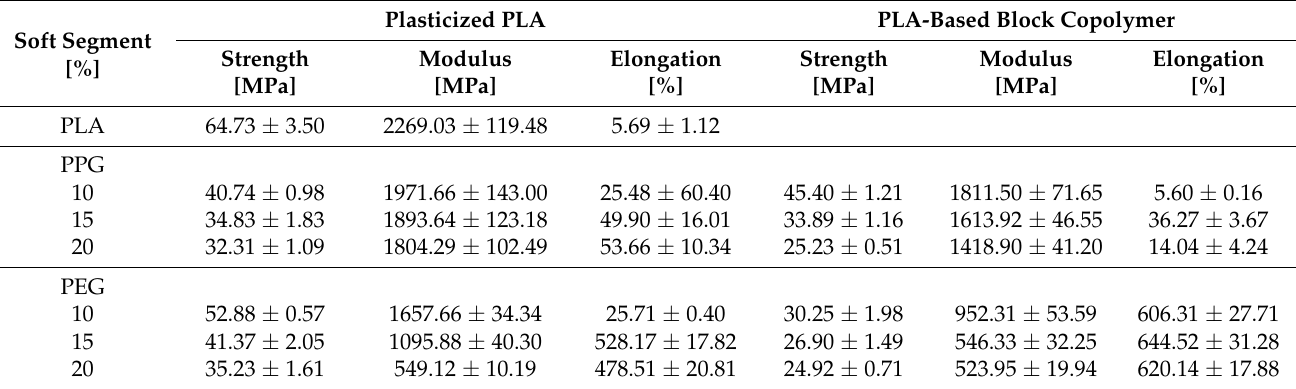
Table 2. Tensile strength, Young’s modulus, and elongation at break of various plasticized PLA and PLA-based block